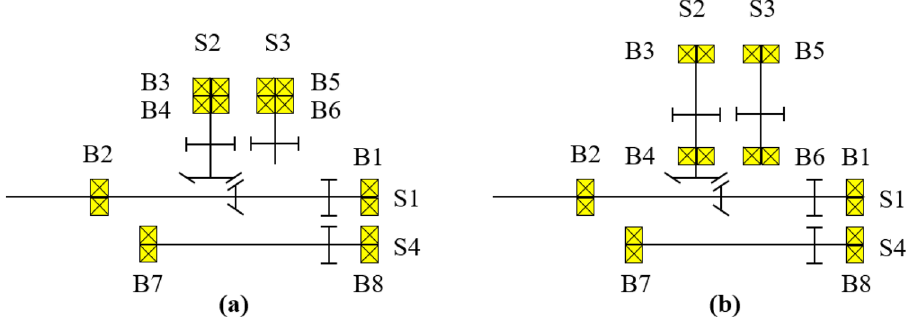
Table 7. Reaction force of bearings on load level 8 in LDD.